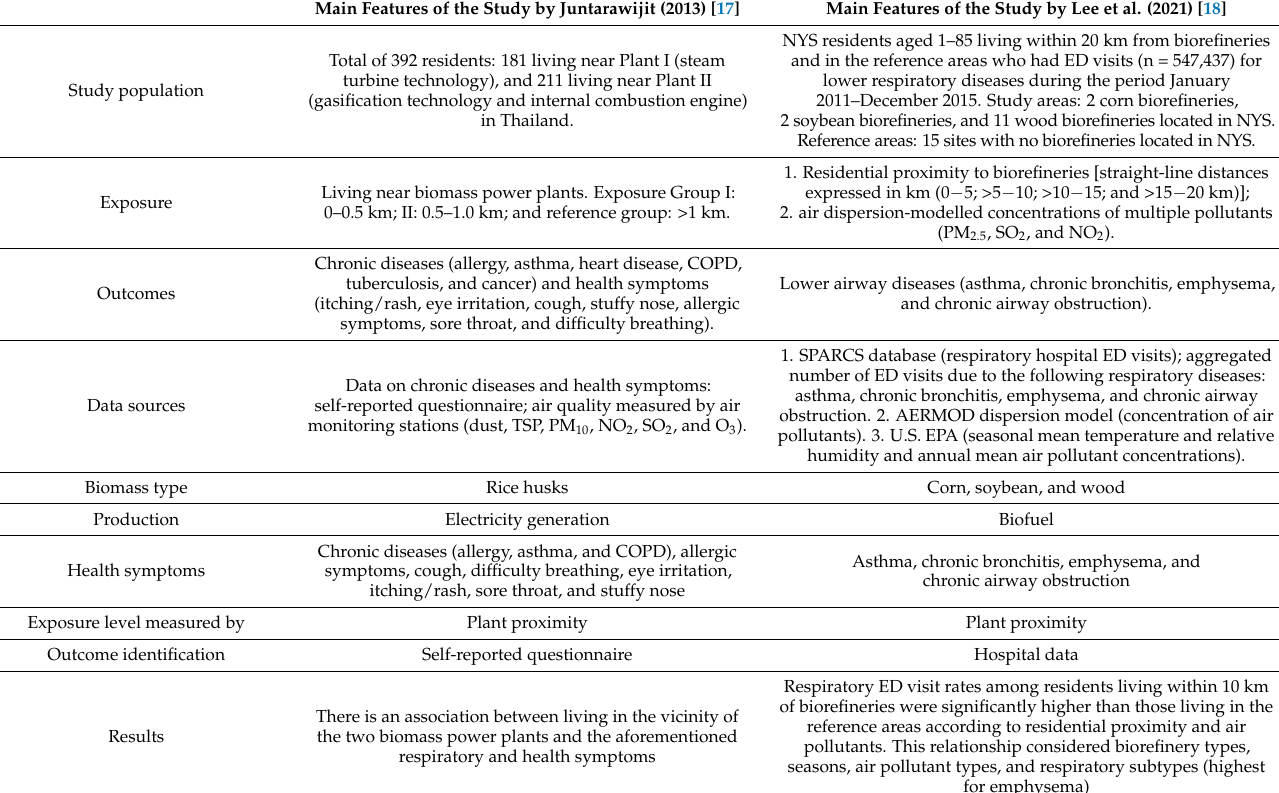
Table 2. Main features of the included epidemiological studies in residential